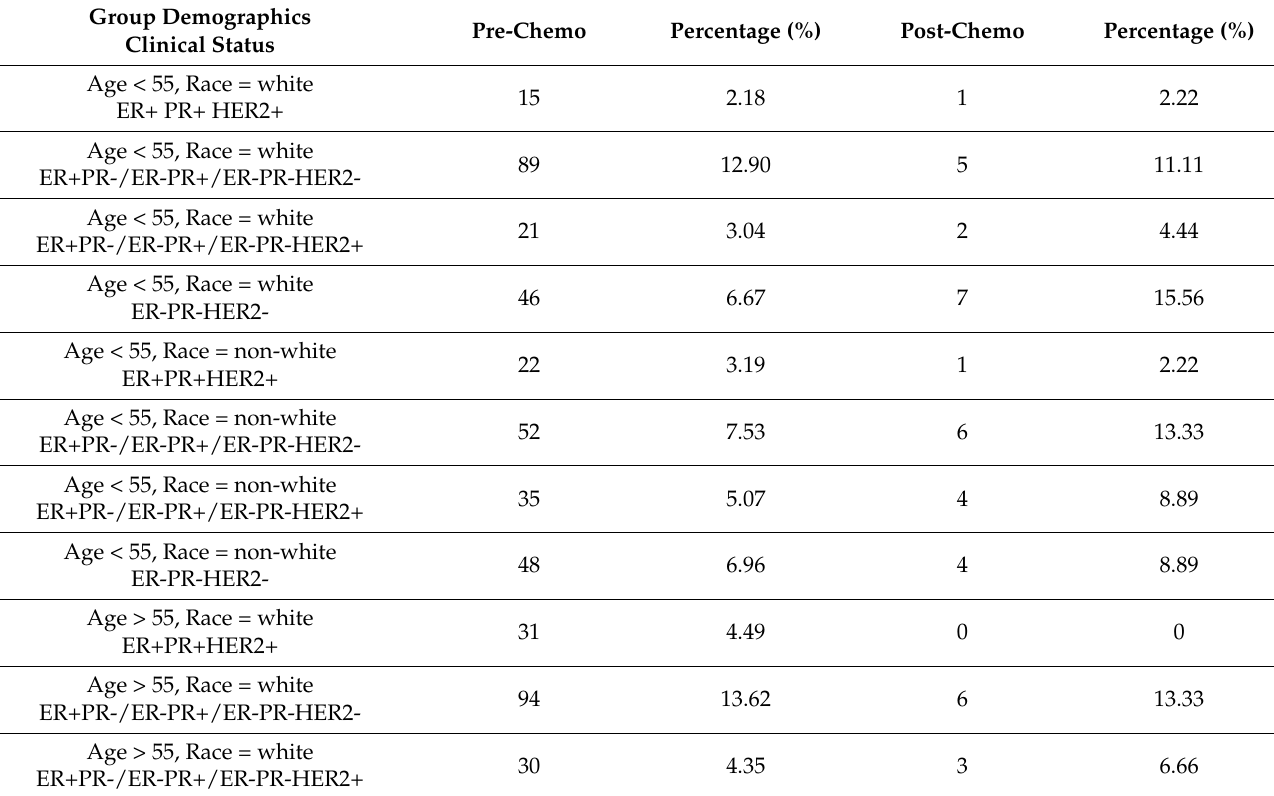
Table 2. Matching scheme for the second cohort of breast cancer samples pre- and post-chemotherapy.